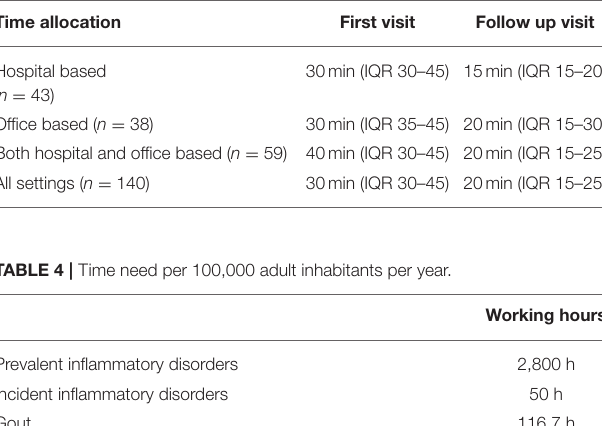
TABLE 3 | Time allocation for clinical rheumatology visits.